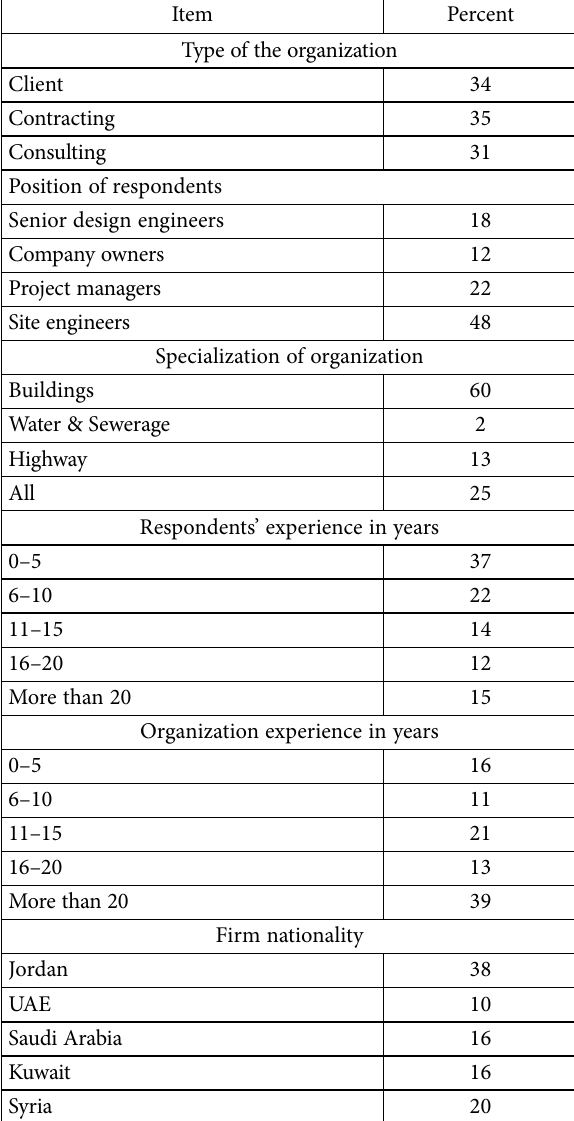
Table 4. Background of respondents and construction firms